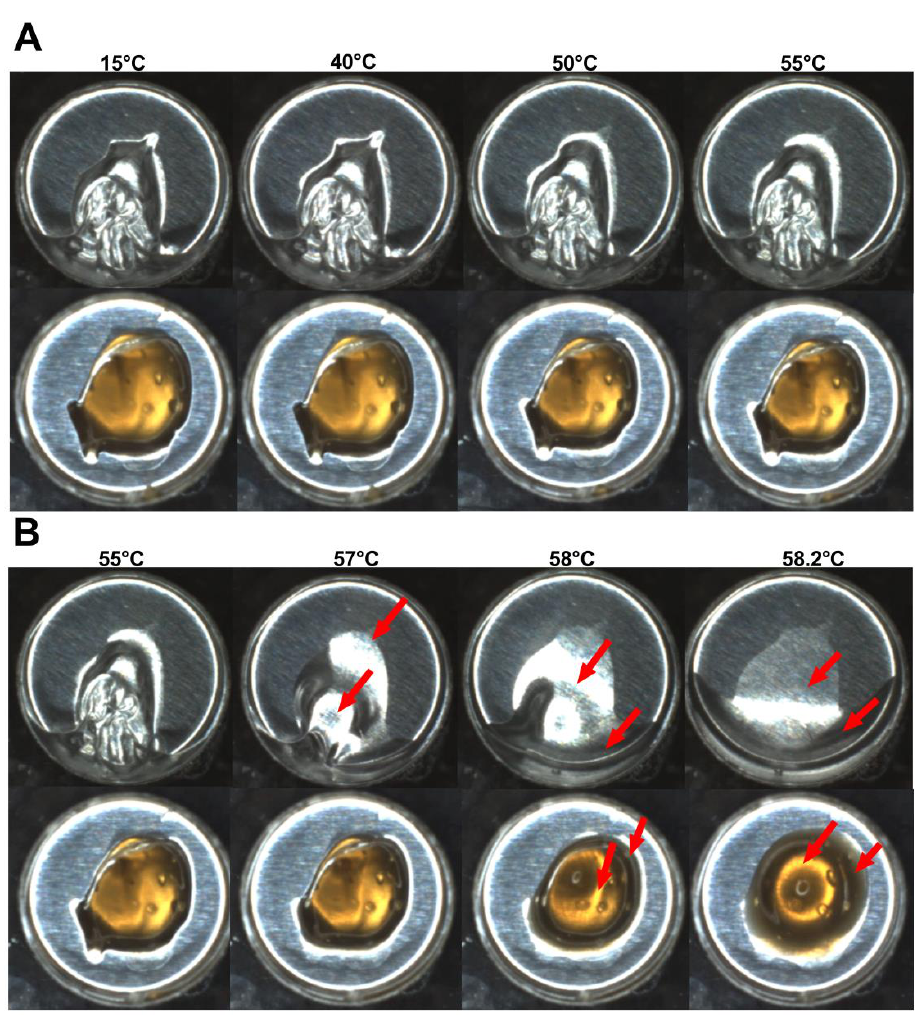
Figure 4. Sample images during the heated portion of the DSC analysis. Images of the following samples, respectively: ( A ) Hydrogel without (top panel) and VADE-loaded-hydrogel (bottom panel) are shown, respectively; from the left to the right at 15, 40, 50, and 55 °C. ( B ) Hydrogel without (top panel) and VADE-loaded-hydrogel (bottom panel) are shown, respectively; from the left to the right at 55, 57, 58, and 58.2 °C. The arrows show the main physical changes observed in the samples.